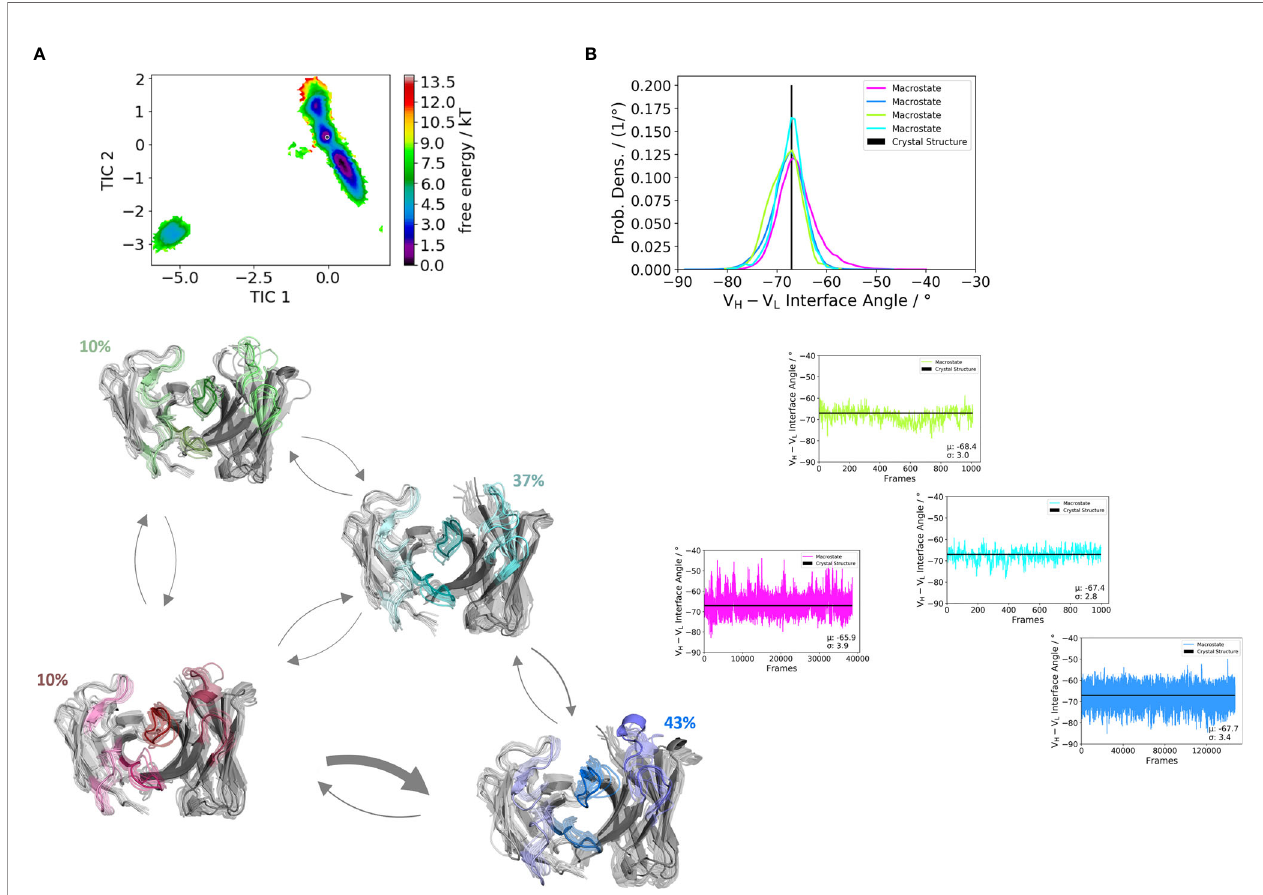
FIGURE 5 | Germline pairing speci fi c paratope states in solution for the H3-23:L3-20 (5I1C) Fab. (A) Shows the paratope states, the free energy landscape, the macrostate ensembles and the respective VH and VL orientations for the 5I1C antibody. The thickness of the arrows corresponds to the obtained transition timescales. The thicker the arrow the faster the transition. The macrostate ensembles are arranged according to the shape of the tICA. (B) We also observe a small shift in the interdomain angle distributions upon conformational changes in the paratope, which is visualized as probability density distributions. The starting X-ray structure for the underlying simulations is depicted as black dot in the free energy surfaces and as black line in the plots showing the VH-VL angle